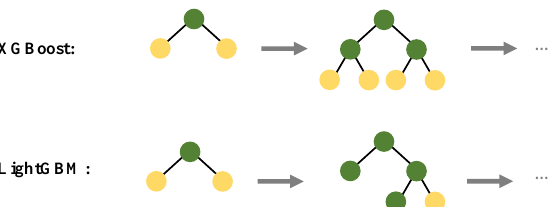
Figure 3. Comparison between XGBoost level-wise horizontal tree growth and LightGBM vertical leaf-wist tree